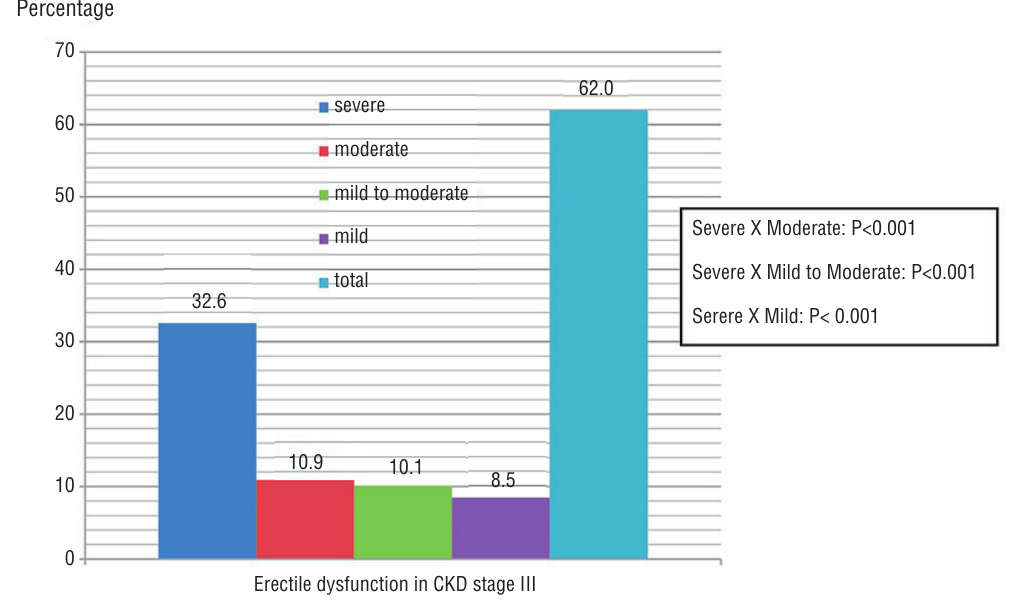
Figure 2 - Comparison of severe versus moderate, mild to moderate, and mild erectile dysfunction in patients with CKD on conservative treatment in stage III. Estimated by chi-square test; P=Statistical significance; CKD=Chronic Kidney